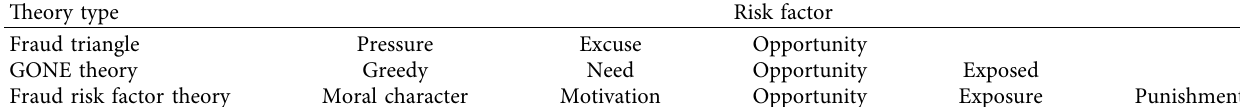
Table 1: Differences and connections between the three kinds of fraud motivation theories. Theory